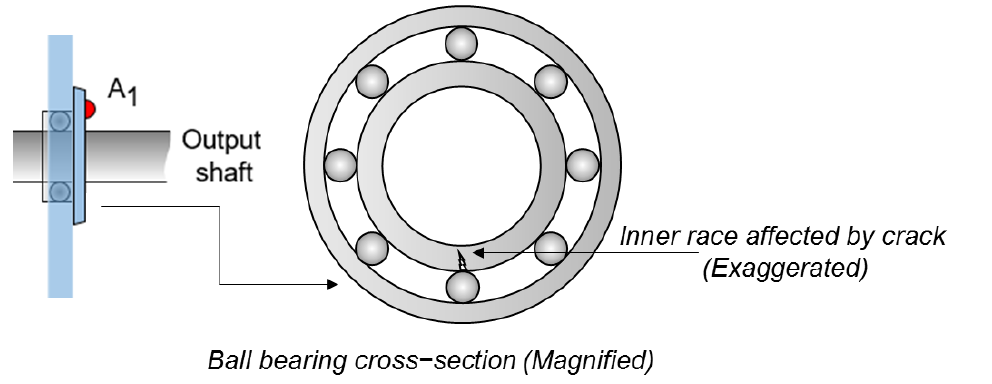
Figure 3. Inner race affected by a